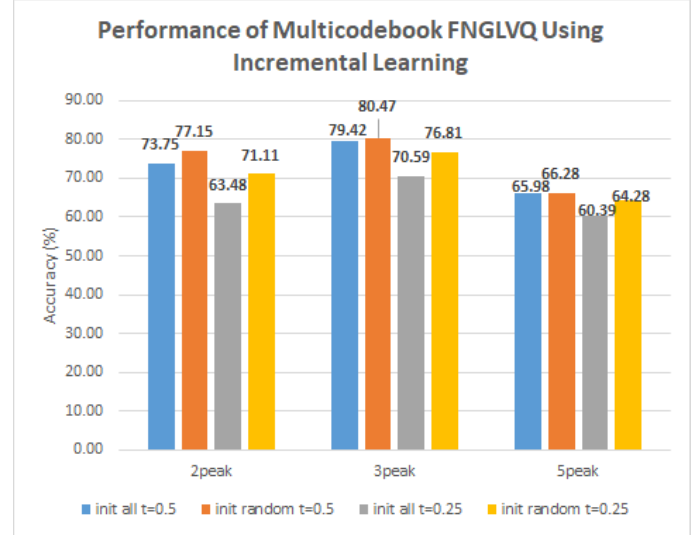
Figure 12. Result of Incremental